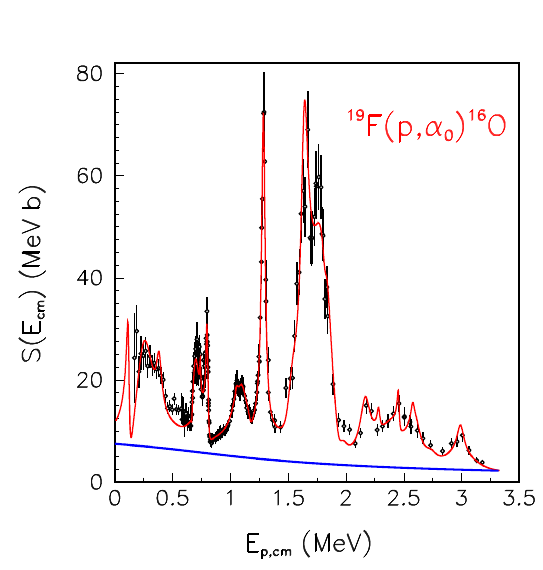
Figure 1. S-factor of the 19 F(p, α 0 ) 16 O reaction as a function of the energy in the center of mass reference frame. The red line is the result of the R-matrix analysis while the blue line represents the direct contribution used to reproduce the